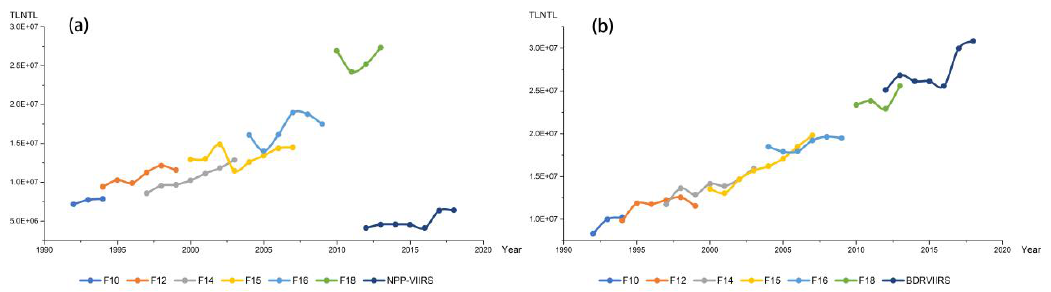
Figure 6. Total light value (TLV) of non-calibrated nighttime light (NTL) data across China ( a ) and that of calibrated NTL data ( b ).